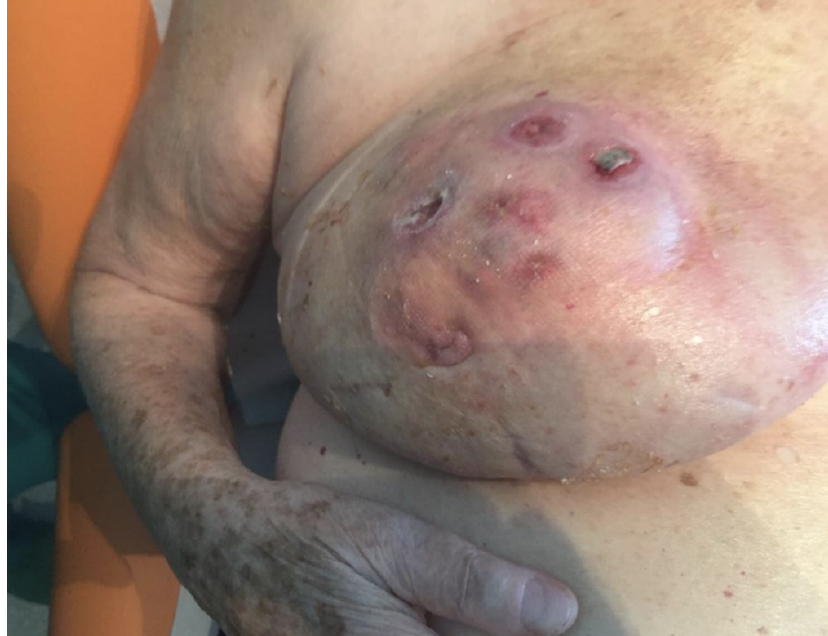
Figure 7. After 25 days.